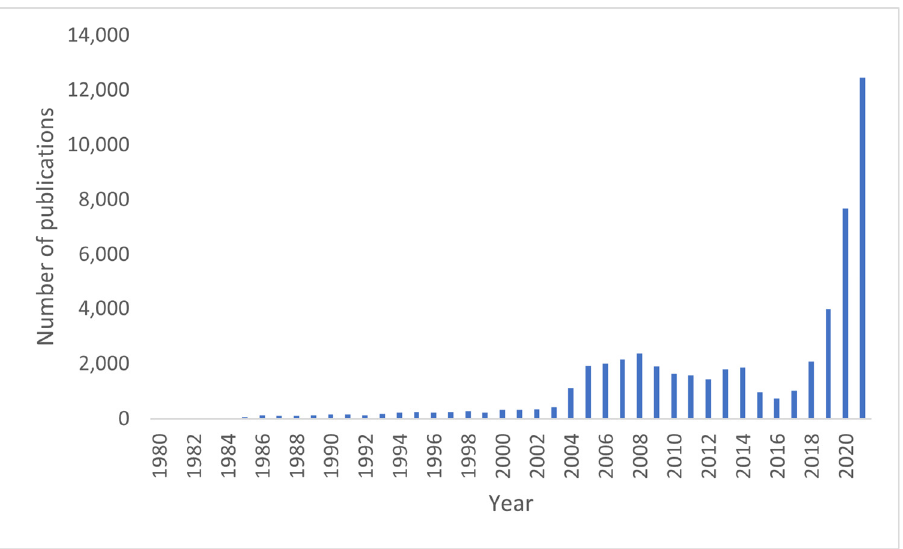
Figure 1. Number of PubMed search results for “artificial intelligence” with an exponential growth in numbers of published articles after 2016.